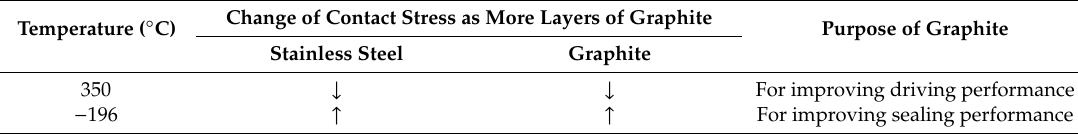
Table 8. Comparison of contact stress behavior of laminated seal at 350 ◦ C with that at − w96 ◦ C. Temperature ( ◦ C)